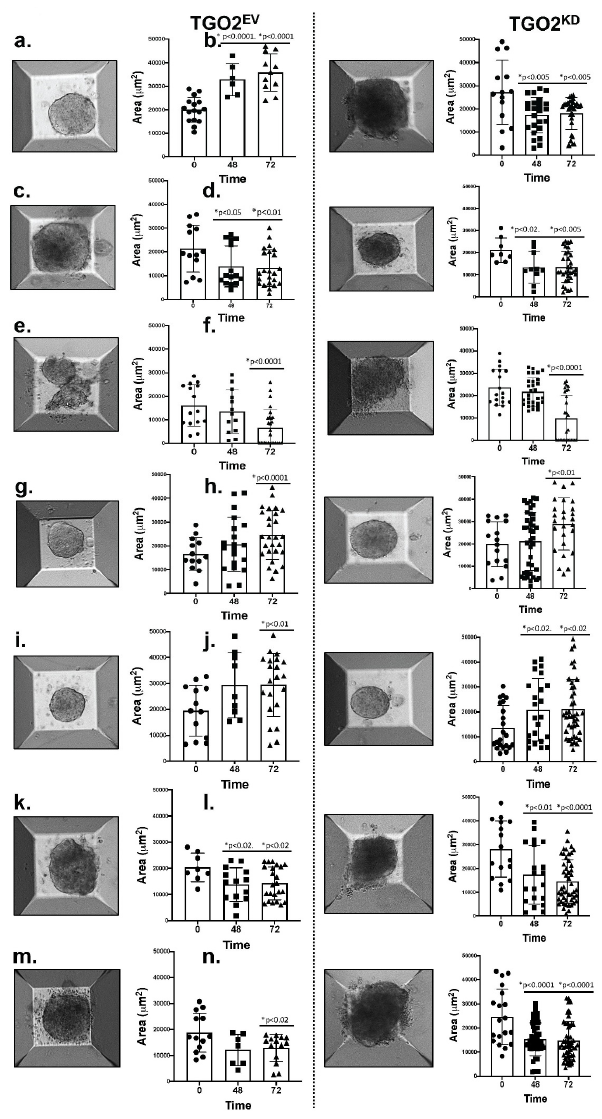
Figure 7. Morphological changes of EV and HER2 shRNA transduced organoids in PD-L1- huTGO/immune cell co-cultures as a result of different treatment conditions. huTGO